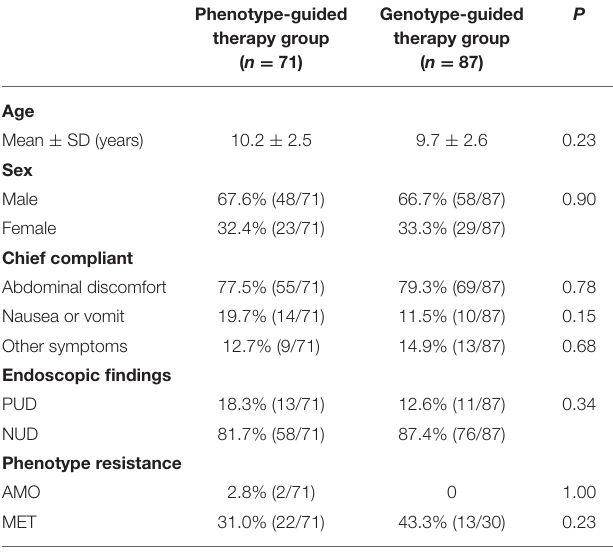
TABLE 2 | Basic characteristics and antibiotic resistance rate of the subjects.